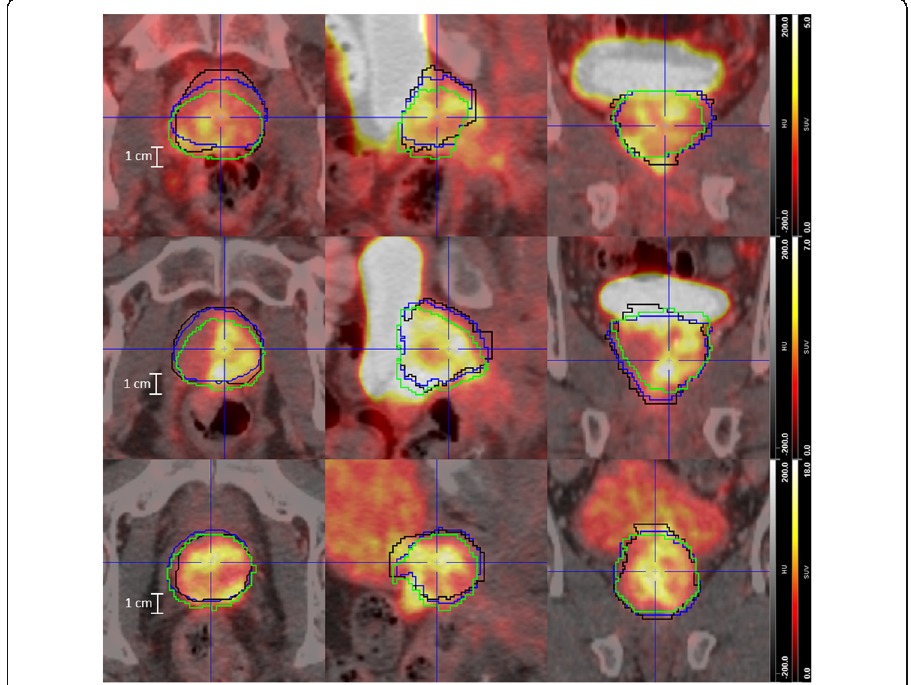
Fig. 3 Localization of the prostate according to ManReg and ManRegMI. PSMA-PET/CTs for patient 1 ( top ), 2 ( middle ), and 3 ( bottom ) in axial, sagittal, and coronal views each (from left to right). The images show the CT- based delineation of the in vivo prostate ( black ), the coregistered ex vivo contour ( blue , ManReg method), and the result of applying the PET-based MI transformation onto the latter ( green , ManRegMI). The largest shift (about 7 mm) in case of patient 1 places the ex vivo contour slightly into the rectum according to the CT image. However, the MI algorithm still yields a well-justified transformation, as such a shift can be easily explained as an inevitable consequence of a misalignment between CT and PSMA-PET (see